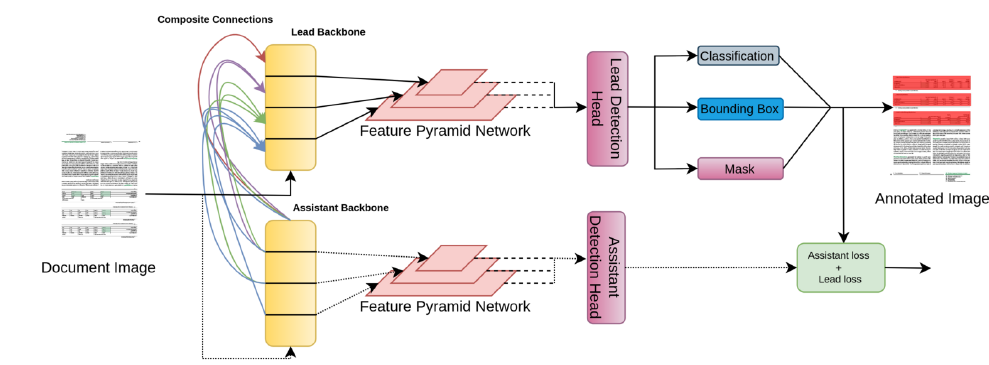
Figure 3. The detection pipeline and architecture of CBNetV2 consists of the lead network and the assistant network. The lead and assistant networks are used during training, where the assistant backbone and detection head provide additional supervision. During inference, only the lead network is